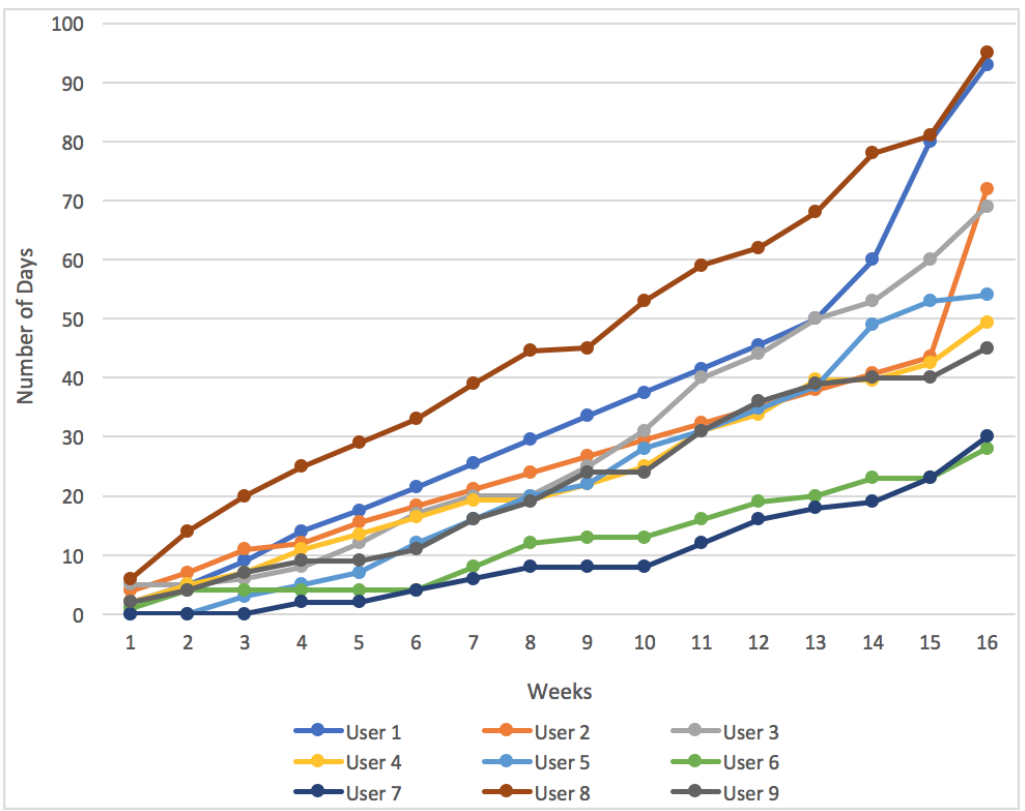
Figure 14. Number of days over the duration of the study in which users consulted social statistics.